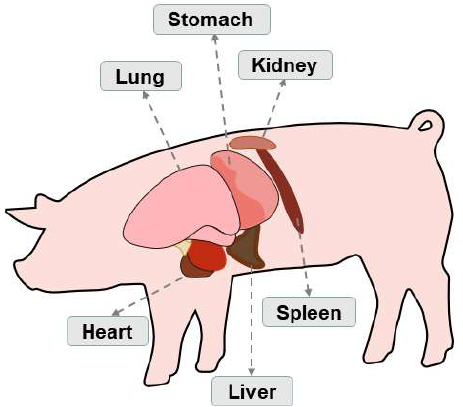
Figure 1. Distribution of heart, liver, spleen, lung, kidney, and stomach in the pig.